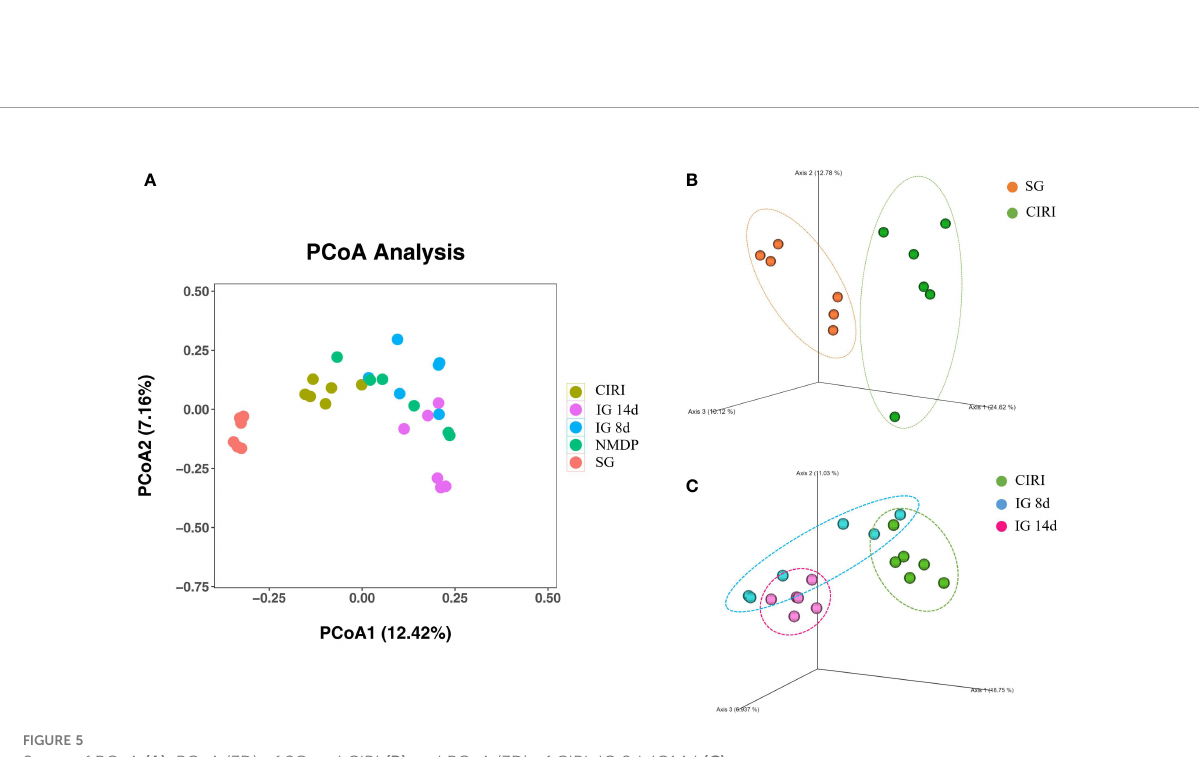
FIGURE 5 Score of PCoA (A) , PCoA (3D) of SG and CIRI (B) and PCoA (3D) of CIRI, IG 8d, IG14d (C)